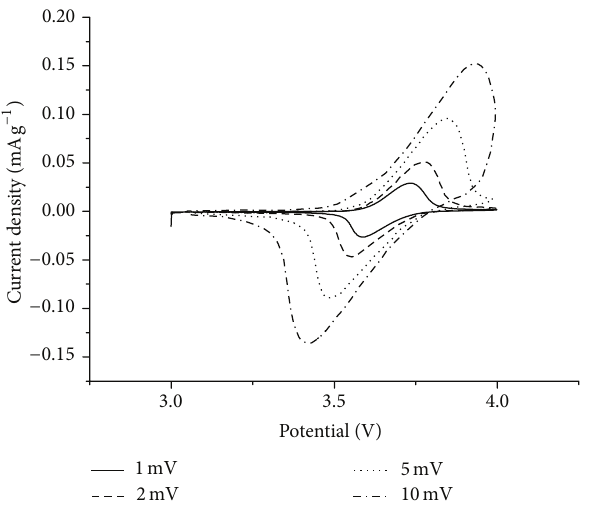
Figure 9: The capacity difference with different electrolytes.